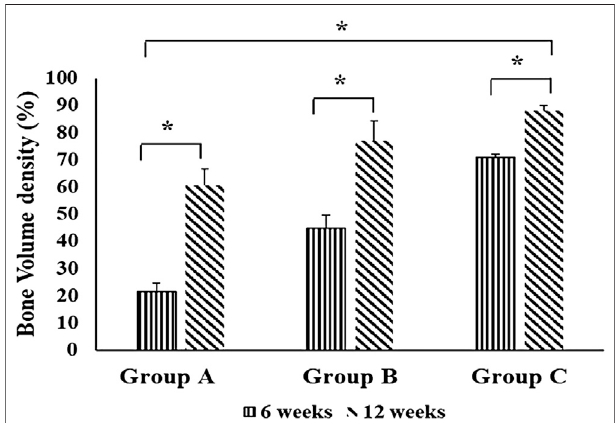
FIGURE 2 | Comparison of bone volume densities between groups (group A (control), group B (chitosan gel), group C (OPG-chitosan gel)). at 6 and 12 weeks. Data are expressed as mean ± SD ( n (cid:1) 3). *denotes signi fi cant difference in bone volume ( p < 0.05) found between different groups.